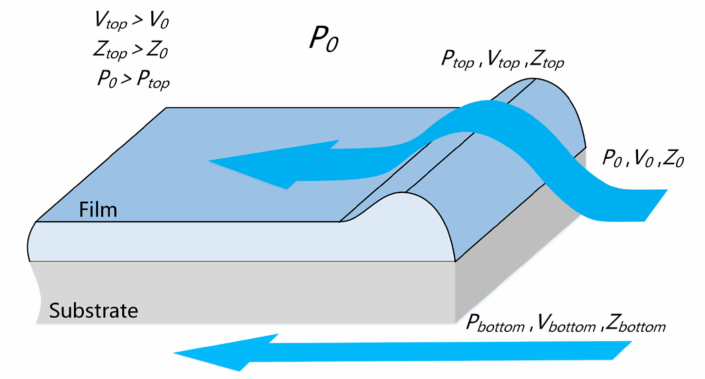
Figure 12. Explanation of Bernoulli effect